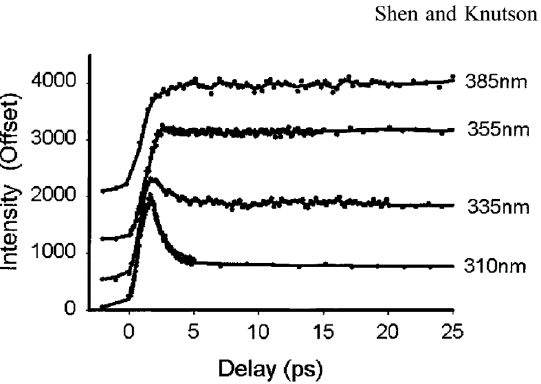
Figure 4. Upconverted fluorescence decay of tryptophan (Trp) at different wavelengths in water. Image reproduced from Journal of Physical Chemistry B 105 (2001) 6260.